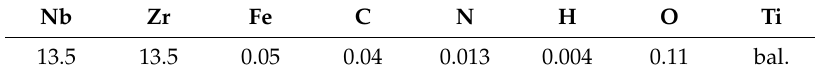
Table 1. Chemical composition of the Ti–13Nb–13Zr alloy, weight percent (according to manufacturer's certificate).